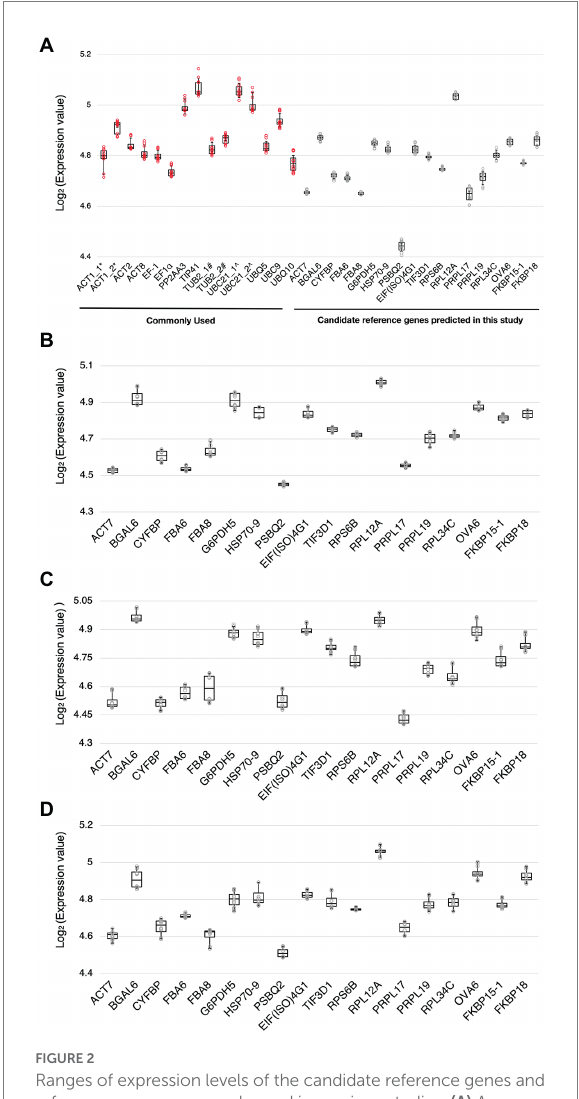
FIGURE 2 Ranges of expression levels of the candidate reference genes and reference genes commonly used in previous studies. (A) A boxplot showing the range of expression values [log 2 ( C t value)] of the candidate reference genes and the reference genes commonly used in previous studies obtained by RT-qPCR when subjected to Pst DC3000 at 0 dpi and 3 dpi. (B–D) Boxplots showing the range of expression values [log 2 ( C t value)] of the candidate reference genes when subjected to jasmonic acid (JA) (B), salicylic acid (SA) (C) , and abscisic acid (ABA) (D) treatments and the corresponding mock control treatments. The solid line inside each box represents the median expression value and the lower and upper edges of the boxes denote the 25 th and 75 th percentiles, while the whiskers represent the maximum and the minimum values. Each dot represents the expression value calculated from each technical replicate of RT-qPCR. Three technical repeats were performed for each biological replicate, with two biological replicates in